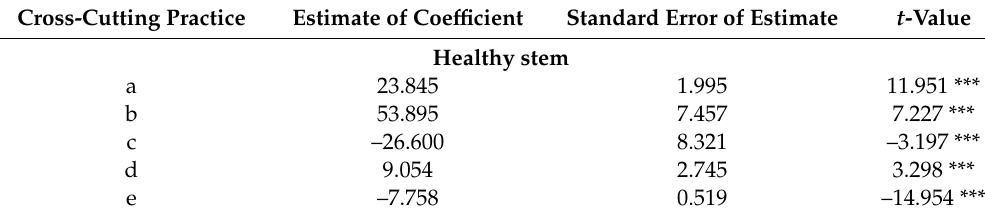
Figure 3. Stem processing time observations ( A ), the calculated curves of stem processing time ( B ) (Table 4), and changes in stem processing time via cross-cutting practice ( C ) compared to the cross-cutting practice two (Zero level = cutting of one pole of 3 m) as a function of the stem volume. Table 4. Regression models for the stem processing time consumption by cross-cutting practice.